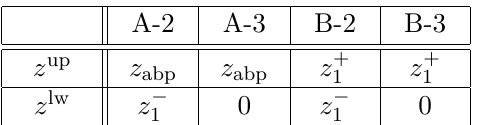
Table 5 . A summary of the integration interval of z 1 , where z ± while z abp in table 3. The probabilities are zero for the other